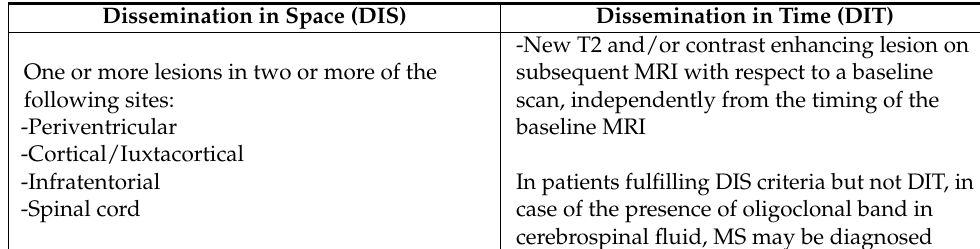
Table 1. The 2017 revision of McDonald’s diagnostic criteria for multiple sclerosis